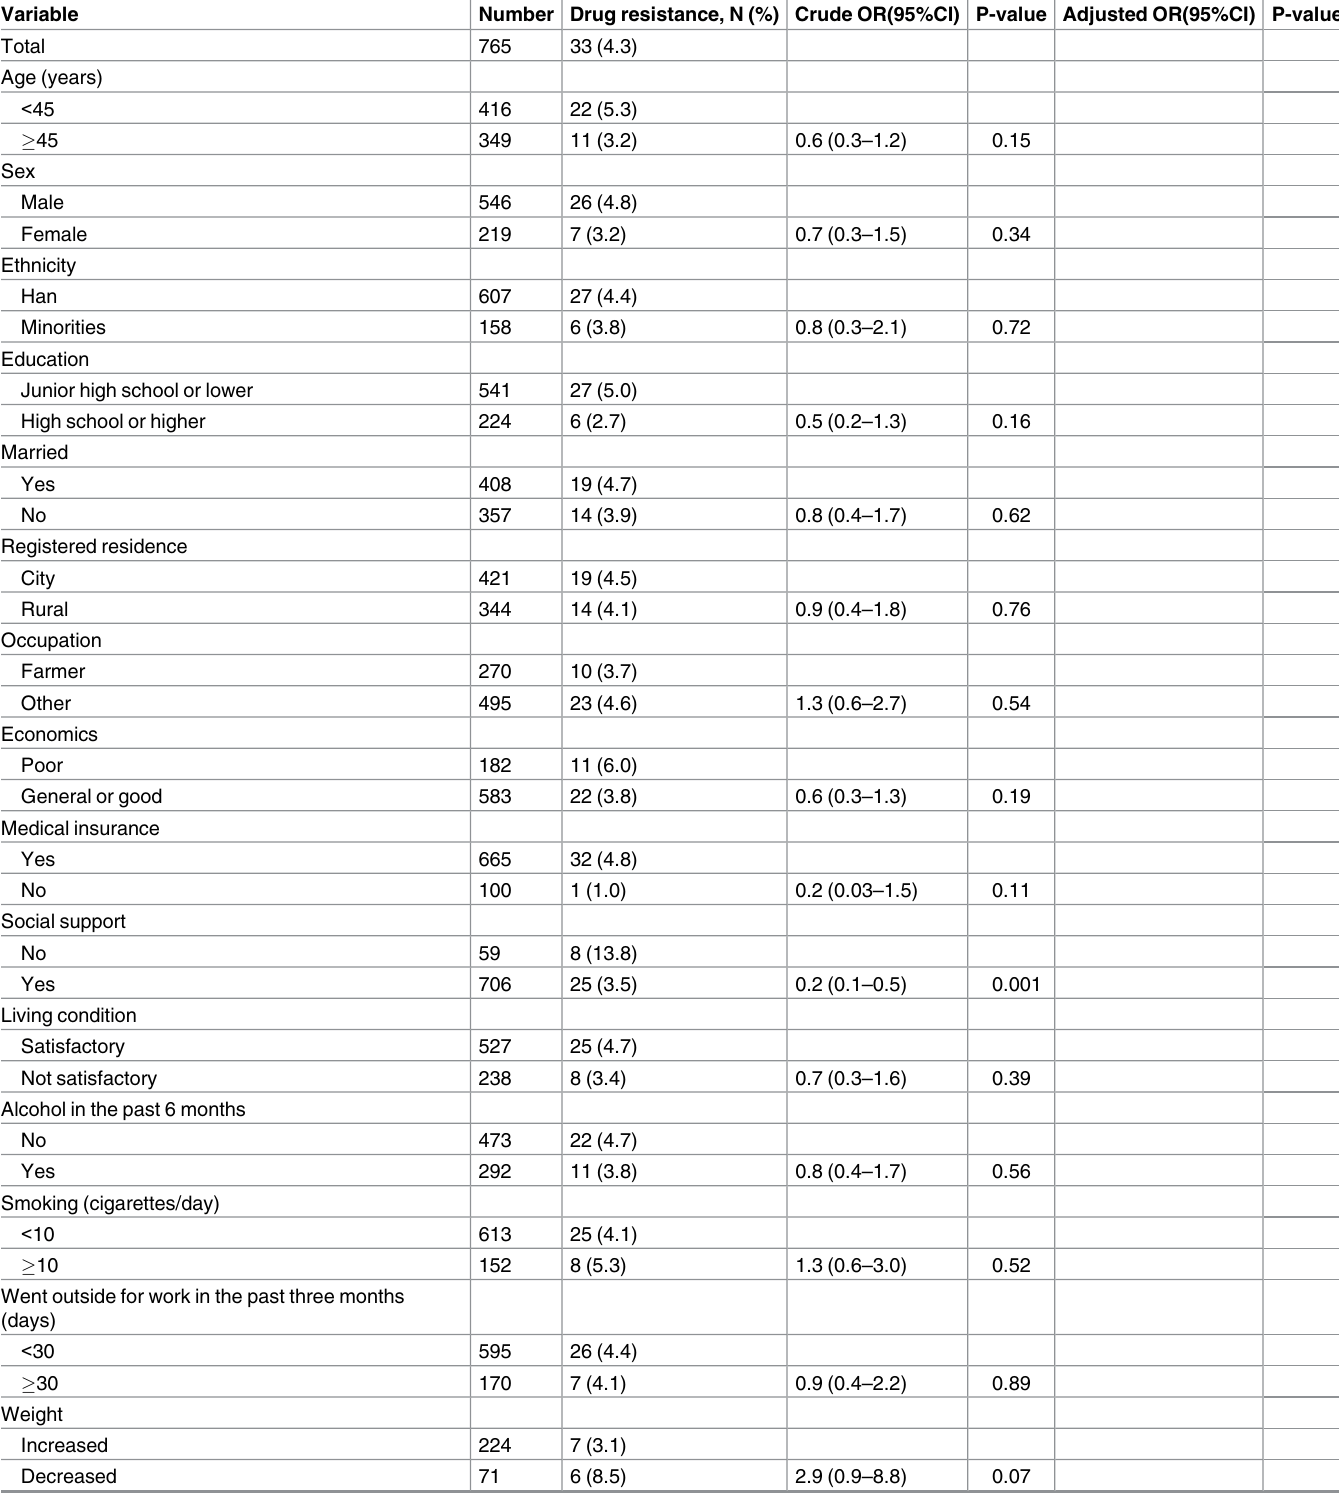
Table 3. Factors associated with HIV drug resistance among patients receiving ART in China.